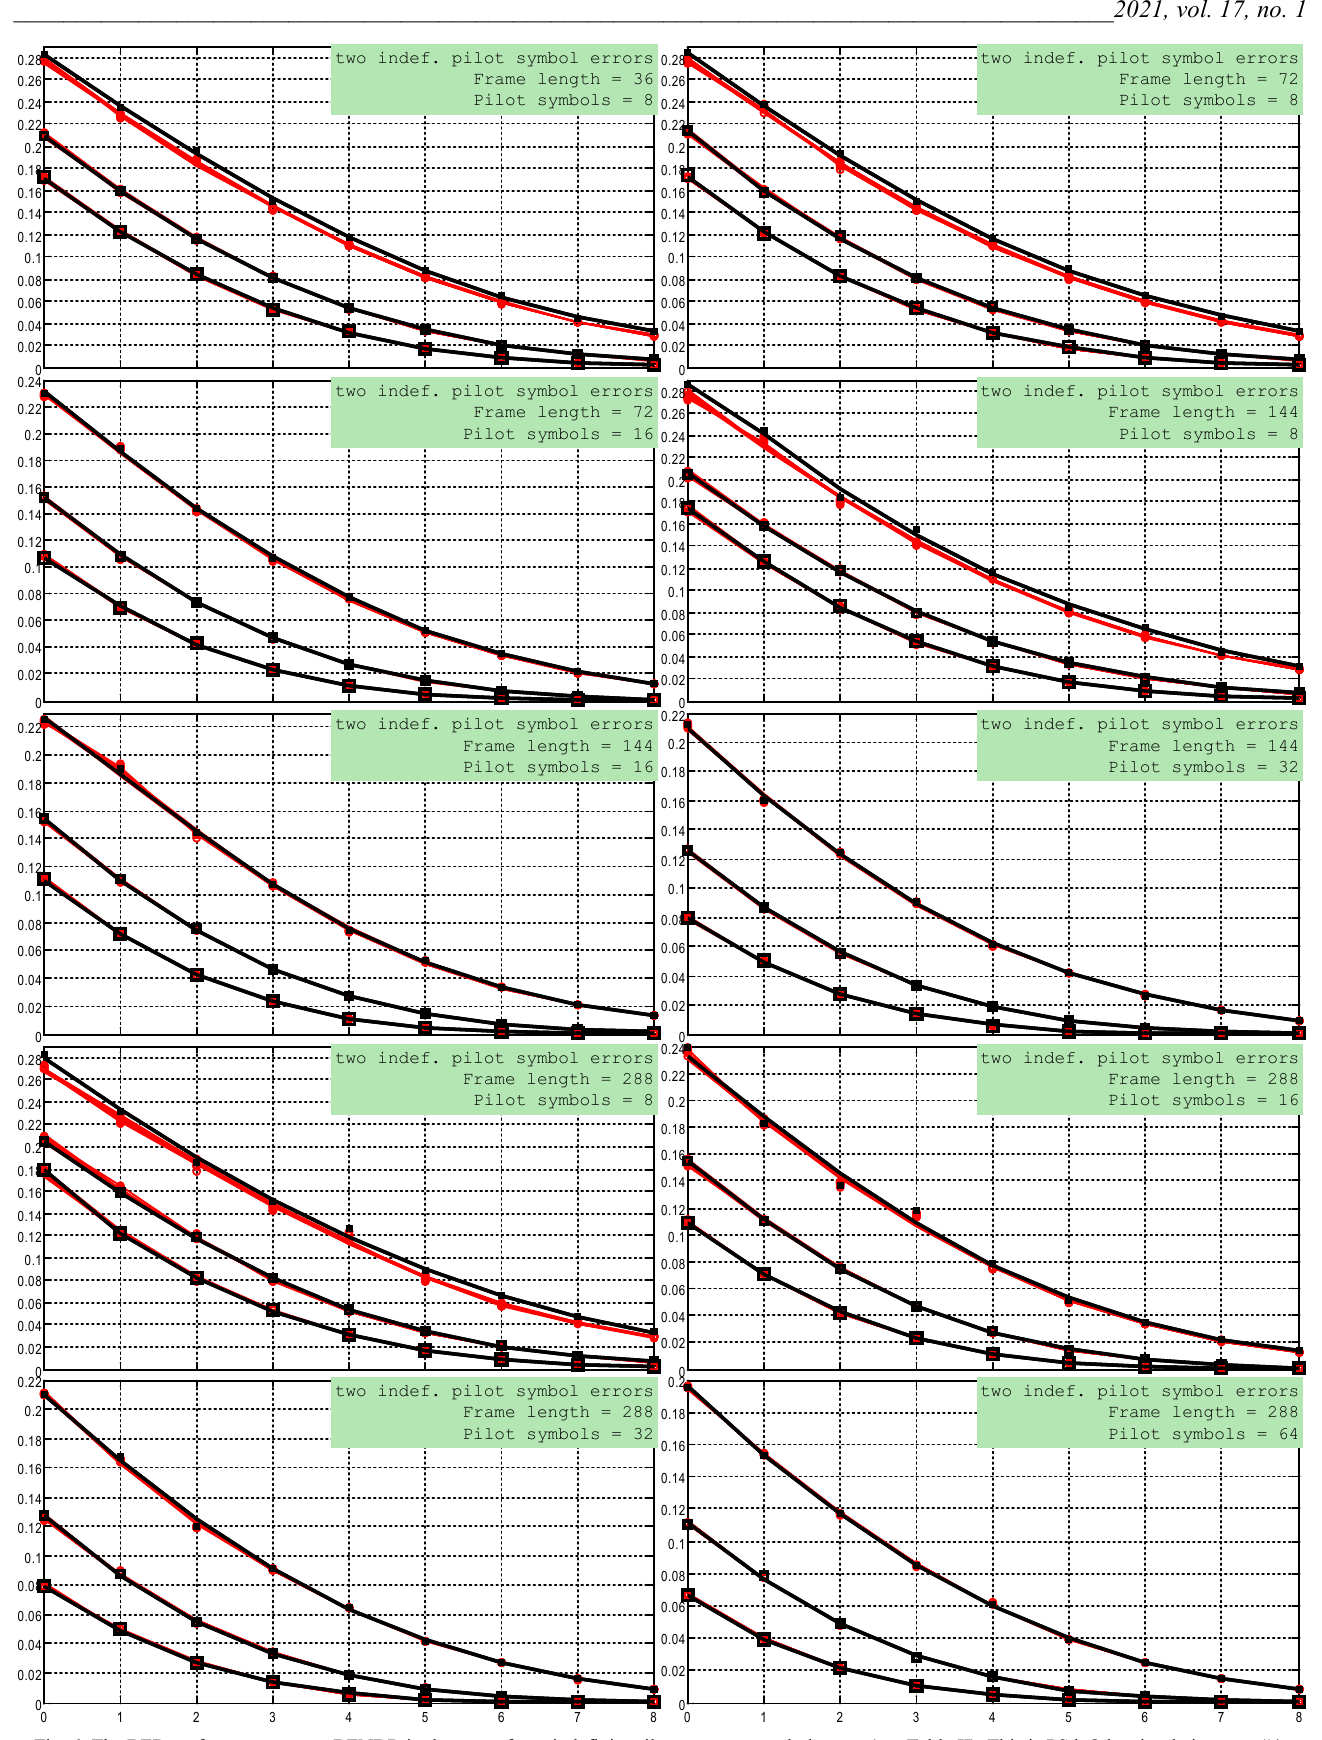
Fig. 6. The BER performance versus BENDR in the case of two indefinite pilot sequence symbol errors (see Table II). This is PSdeO by simulation case #4.